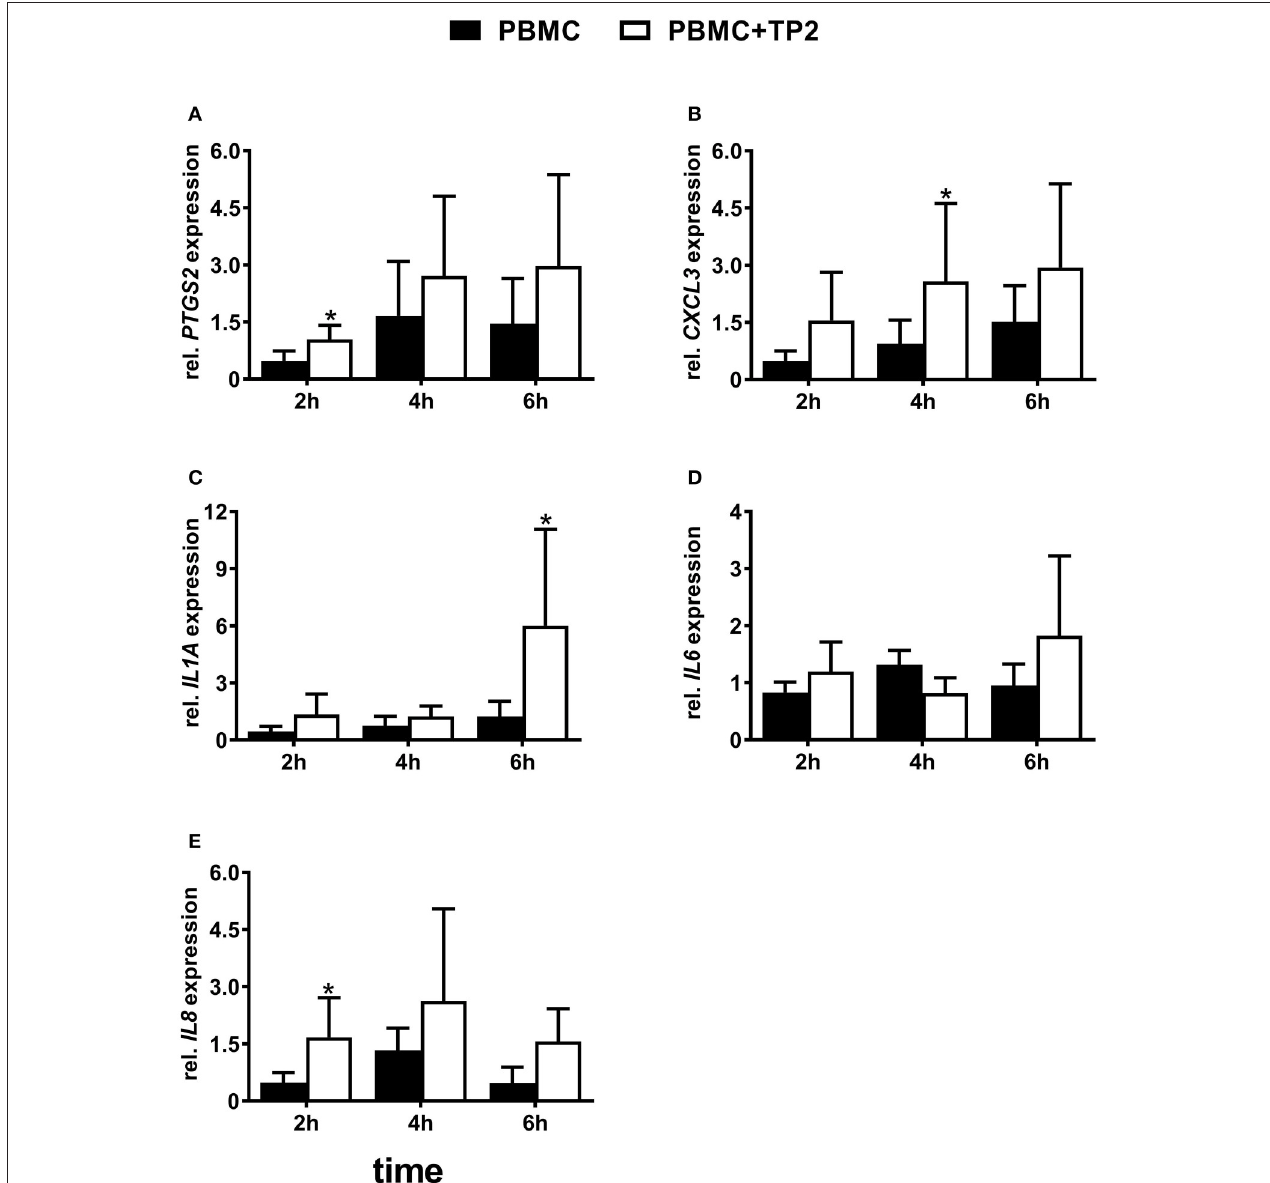
FIGURE 7 | Relative mRNA expression of (A) PTGS2 , (B) CXCL3 , (C) IL1A, (D) IL6 , and (E) IL8 in PBMC co-cultured with live TP2 at MOI = 0.1 up to 6 h. The bars show means ± SEM of mRNA expression values from different cultures ( n = 3 cows). Asterisks above the bars indicate significant different mRNA expression ( P < 0.05) compared with the control (untreated) at the same time